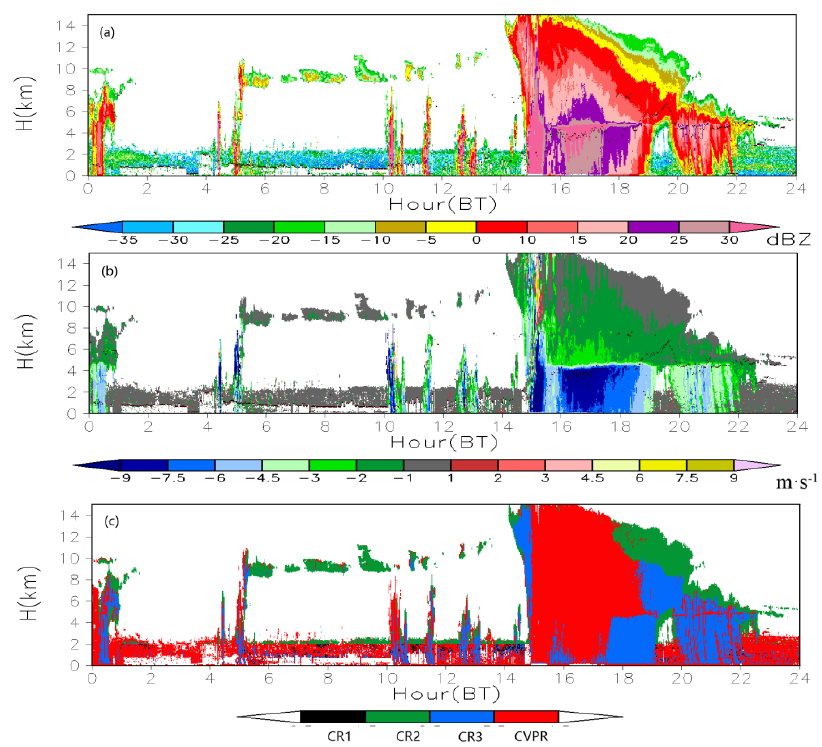
Figure 12. Time-height cross-sections of reflectivity on 4 June 2016: ( a ) the merged reflectivity and ( b ) velocity; and ( c ) data sources for reflectivity and velocity. The black dots in ( a ) and ( b ) indicate the CEIL-derived cloud-base heights. In ( c ), data from CR1, CR2, CR3 and CVPR are shaded in black, green, blue and red, respectively.